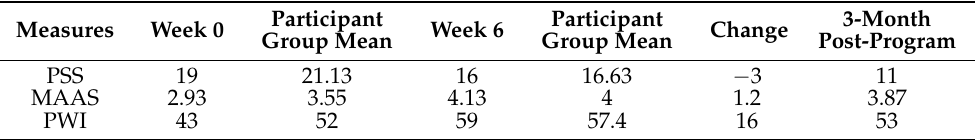
Table 6. Summary of self-report measures for Ashley pre-and post-program and 3-month follow-up.